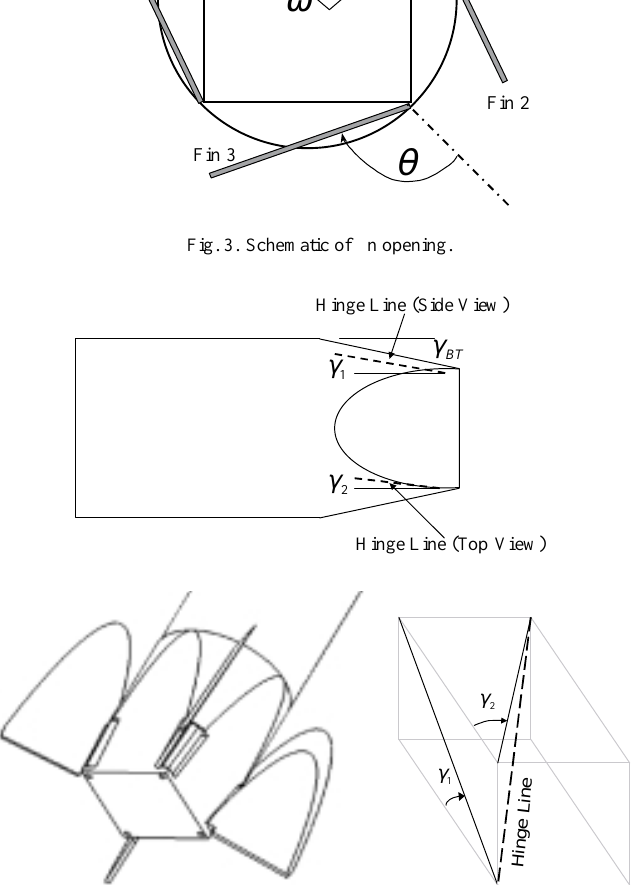
Fig. 4. Views of the compound angle of the hinge